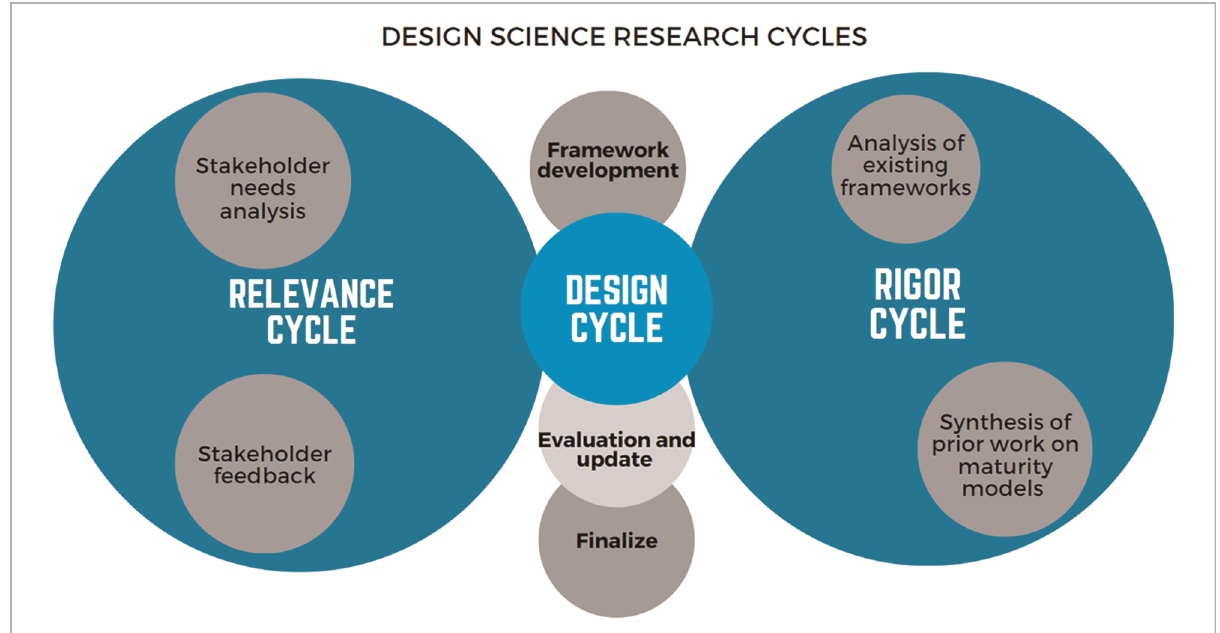
FIGURE 1 Methodological approach to the development of the framework, modi fi ed from Hevner